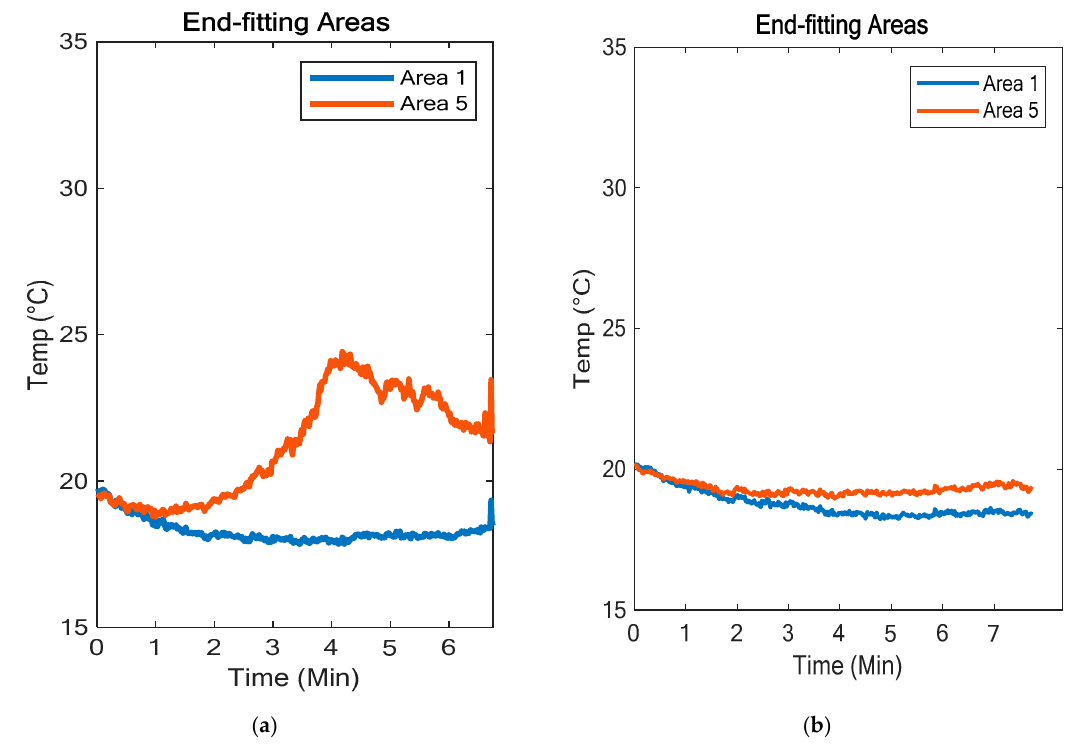
Figure 6. Average temperature of end-fitting areas during the whole test, on ( a ) conventional and ( b ) textured TT4 insulators.